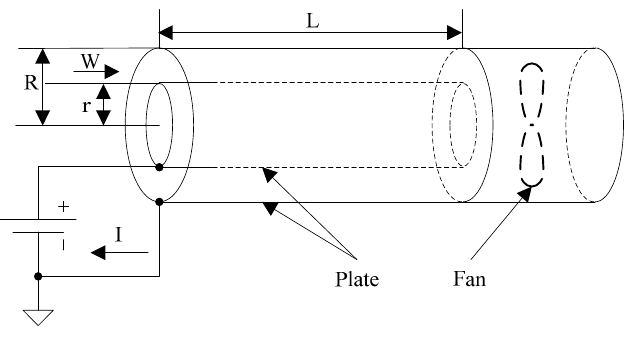
Figure 3. Sensor operation principle.